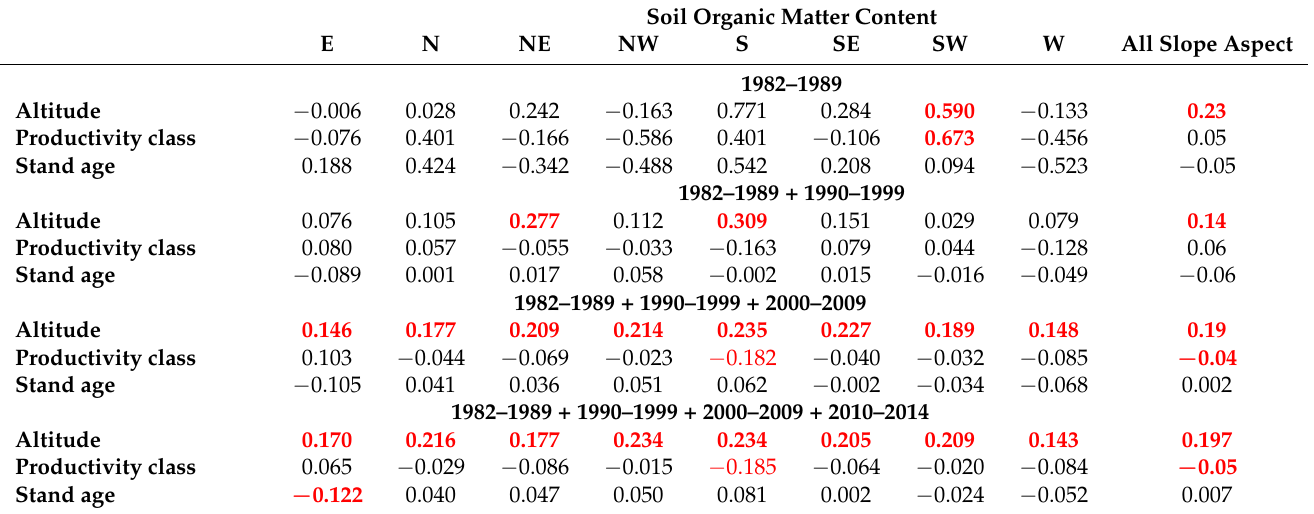
Table 3. Spearman correlation coefficient values for dystric cambisol in the Ao horizon.